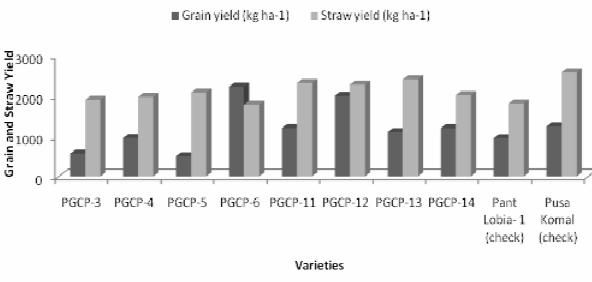
Fig. 1. Grain and straw yield of cowpea as influenced by cultivar differences